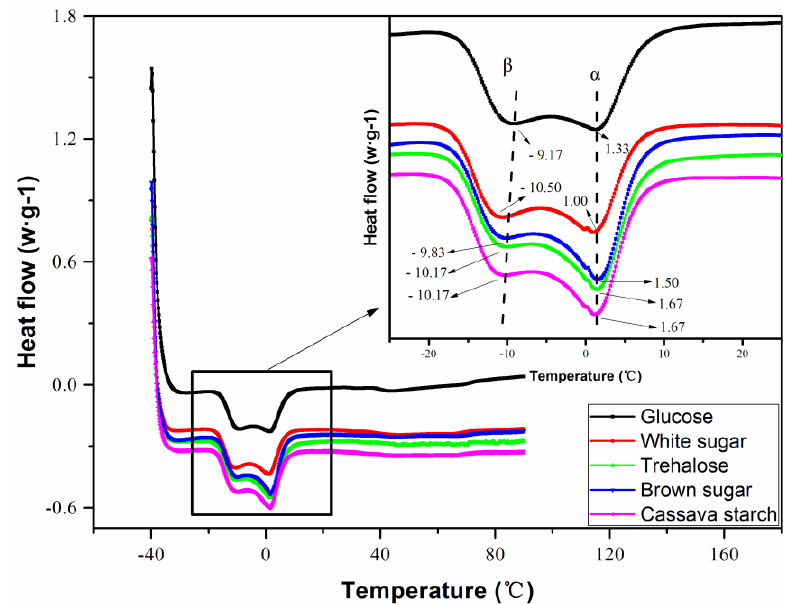
Figure 10. DSC melting curves of NR sample coagulated by different sugars.